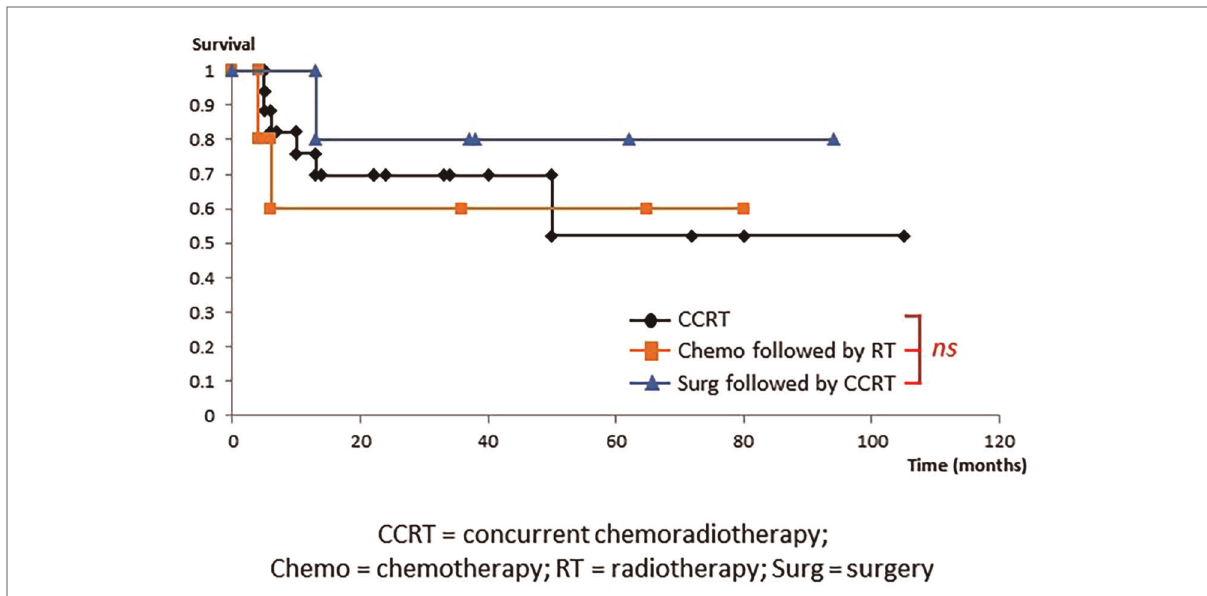
FIGURE 2 Overall survival in the chemoradiotherapy group. OS did not differ among the three treatment groups, namely, concurrent chemoradiotherapy (CCRT), chemotherapy (Chemo) followed by radiotherapy (RT), and surgery (Surg) followed by CCRT.